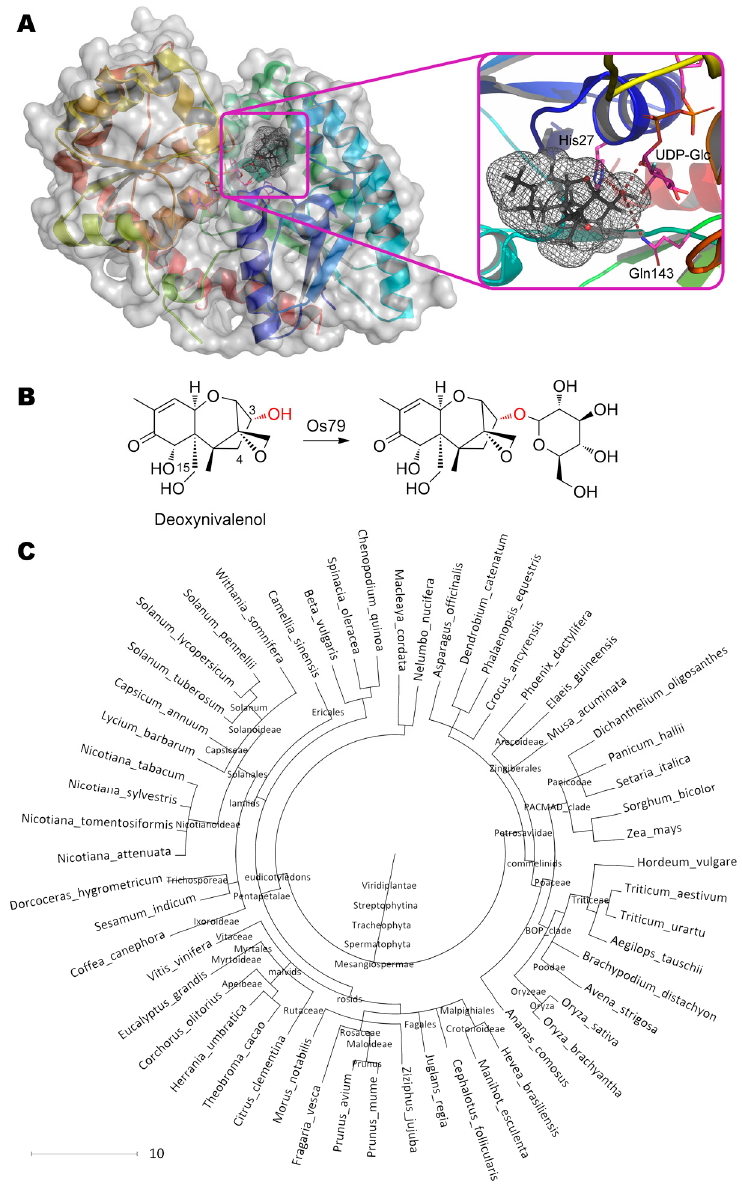
Figure 11. ( A ) Structure of glycosyltransferase OsUGT79 (PDB 5tmd) containing deoxynivalenol in its active center, and ( B ) scheme of substrate conversion with OsUGT79. Position and geometry of substrate binding was determined as described early. ( C ) Phylogenetic tree of microorganisms possessing homologous enzymes found with BLAST.